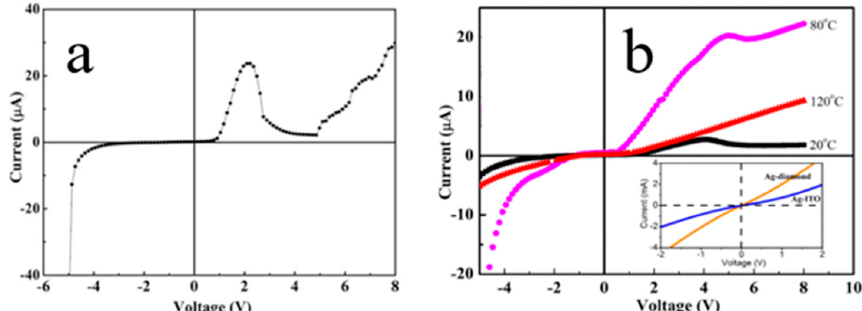
Figure 16. ( a ) I-V plots of the n-ZnO NR/p-BDD heterojunction fabricated with p-degenerated- diamond, displaying the NDR phenomenon. The inset shows a thermal equilibrium energy band diagram heterojunction. ( b ) The I - V curve of the n-ZnO NRs/p-degenerated diamond at 20~120 °C. The inset presents a linear relationship of I - V plots for ohmic contacts of Ag/p-degenerated diamond and Ag/ITO [23,31].